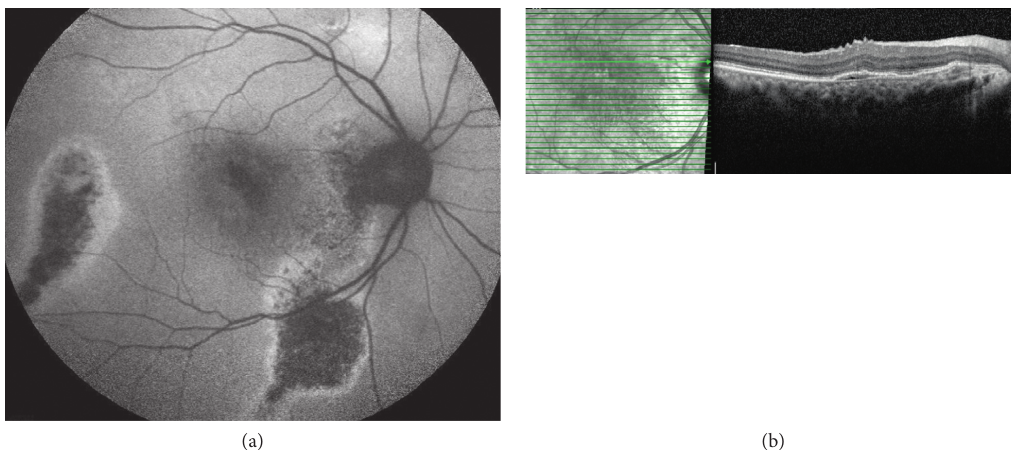
Figure 3: Fundus autofluorescence (FAF) reveals a much larger extent of central serous chorioretinopathy involvement than optical coherence tomography (OCT) alone. (a) FAF shows evidence of water tract signs and areas of confluent hypoautofluorescence (hypo-AF) changes nasal and temporal to the macula, surrounded by edges of hyperautofluorescence changes. The macular area also shows evidence of granular hypo-AF changes, signifying an impaired visual function in this case. (b) OCTscan of the same patient shows resolved subretinal fluid and evidence of retinal pigment epithelium alterations.